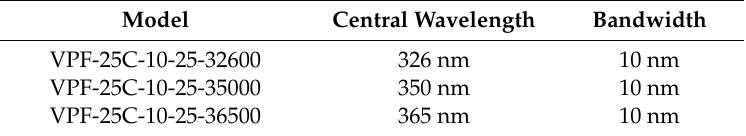
Table 3. Characteristics of the bandpass filters used to select the excitation wavelength.